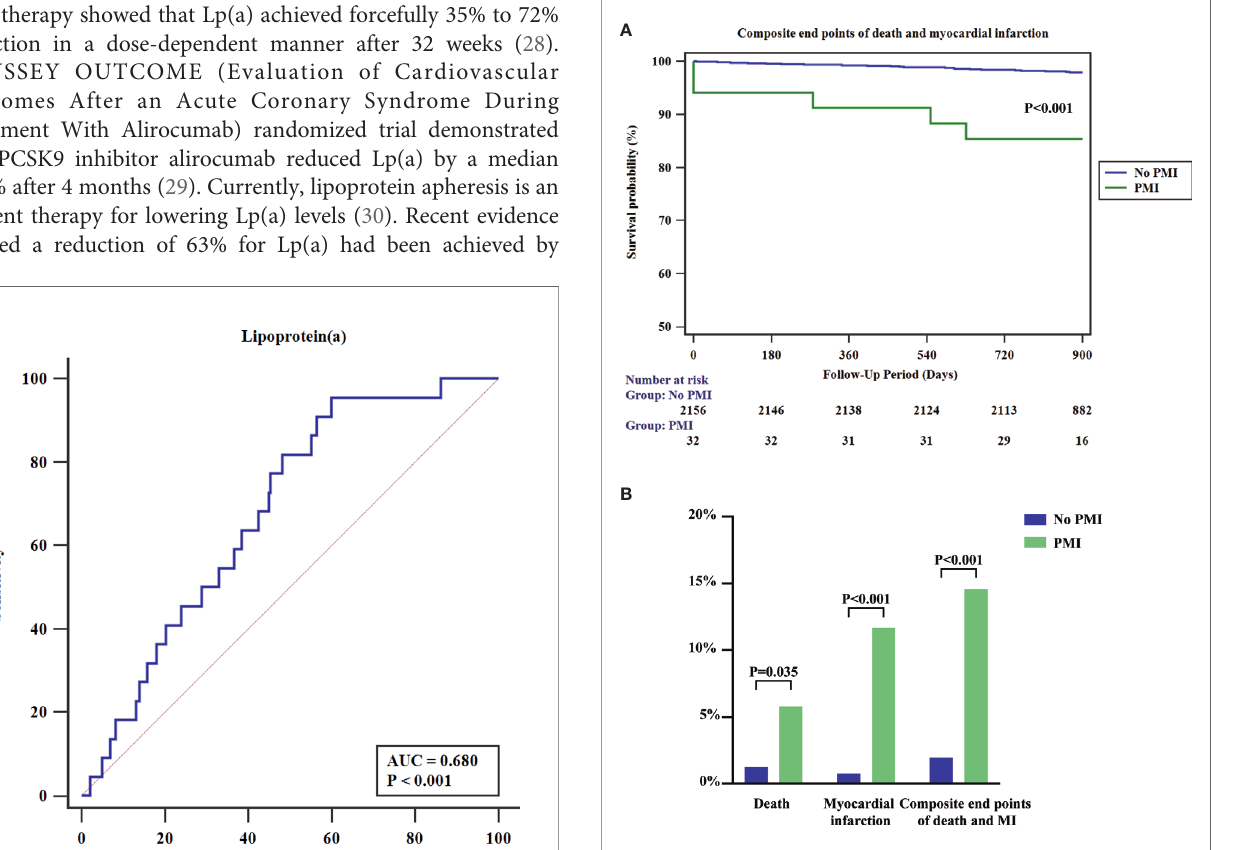
FIGURE 3 | Kaplan-Meier survival curves for composite endpoints of all- cause mortality and myocardial infarction (A) and 2-year rates of the indicated events (B) according to the presence or absence of PMI. PMI, peri- procedural myocardial infarction; MI, myocardial